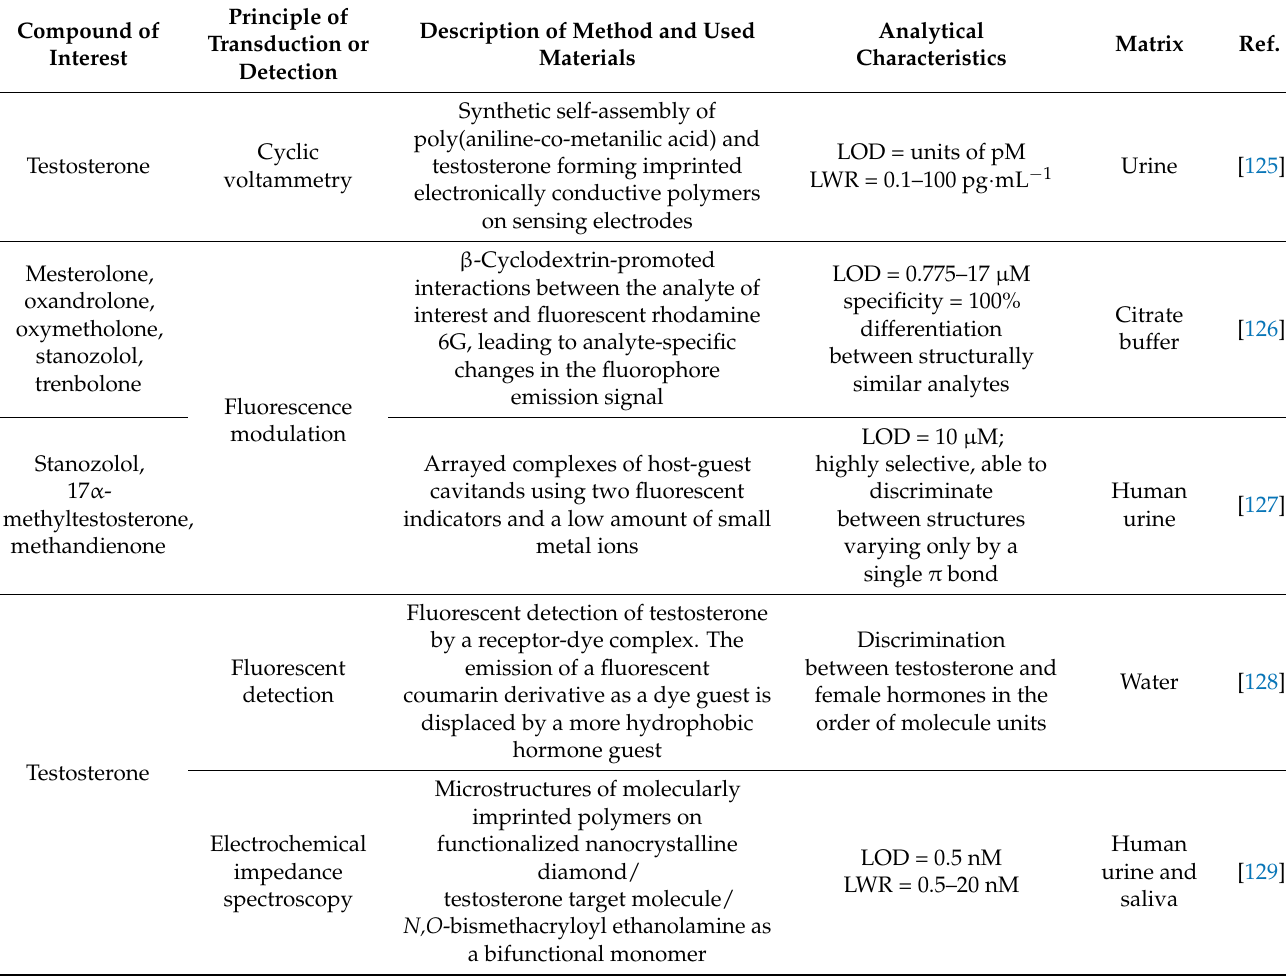
Table 5. Chemically designed artificial sensors for the determination of anabolic-androgenic